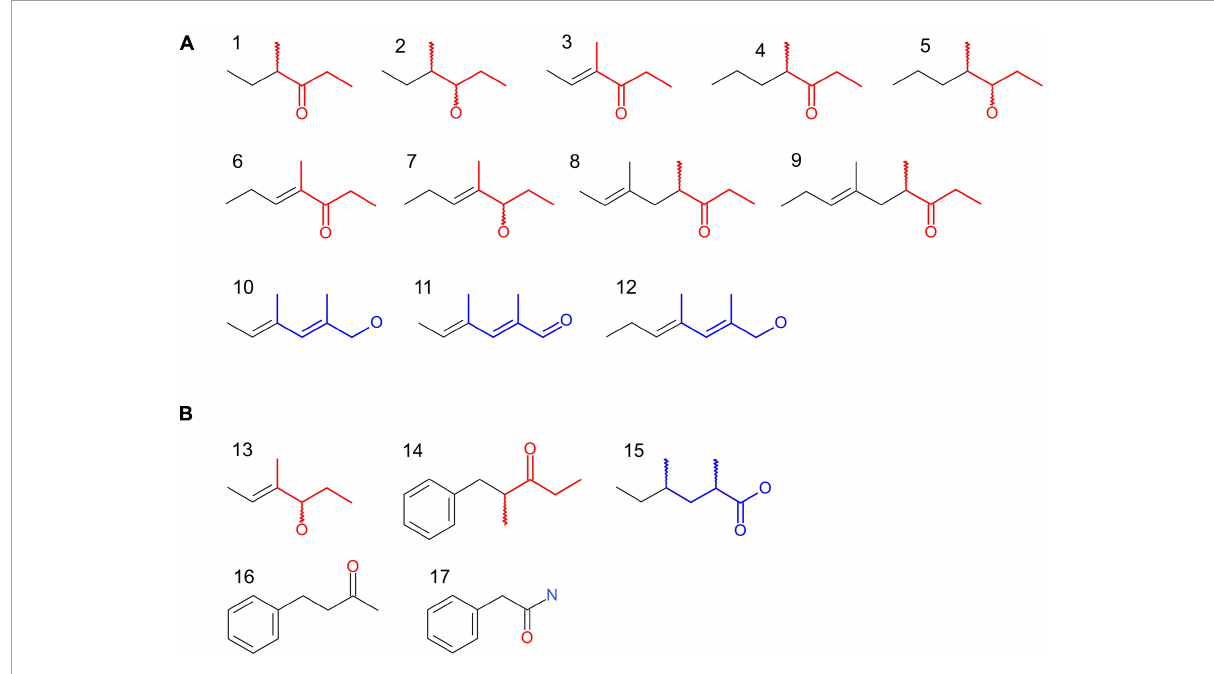
FIGURE1 The growing pool of sclerosomatid compounds (SCs): past and present. Compounds: (1) 4-methyl-hexan-3-one; (2) 4-methyl-hexan-3-ol; (3) ( E )-4-methyl-4-hexen-3-one; (4) 4-methyl-heptan-3-one; (5) 4-methyl-heptan-3-ol; (6) ( E )-4-methyl-4-hepten-3-one; (7) ( E )-4-methyl-4-hepten-3-ol; (8) ( E )-4,6-dimethyl-6-octen-3-one; (9) ( E )-4,6-dimethyl-6-nonen-3-one; (10) ( E,E )-2,4-dimethyl-2,4-hexadien-1-ol; (11) ( E,E )-2,4-dimethyl-2,4-hexadienal; (12) ( E,E )-2,4-dimethyl-2,4-heptadien-1-ol; (13) ( E )-4-methyl-4-hexen-3-ol; (14) ( R )-2-methyl-1-phenyl-pentan-3-one; (15) (2 R ,4 R )-2,4-dimethylhexanoic acid; (16) 4-phenyl-butan-2-one; (17) 2-phenyl-acetamide. (A) SCs as known from literature (Ekpa et al., 1985). Compounds 1–12 are “classical” SCs sensu stricto as already described from North American Leiobunum (nine species) and Hadrobunus (one species). All compounds are acyclic components, arranged in two chemically distinguishable subgroups. Subgroup 1 shows the “4-methyl-3-one” or “4-methyl-3-ol” motif (in red). Subgroup 2 is characterized by the “2,4-dimethyl-1-ol” and “2,4-dimethyl-1-al” motif (in blue). Compounds of subgroup 2 can be converted into compounds of subgroup 1 by a formal addition of an ethyl group to the carbonyl C atom. (B) Novel SCs, as found in the present study for European Nelima spp. and N. paessleri from USA. Compound 13 [=peak A: ( E )-4-methyl-4-hexen-3-ol] is a new SC, showing the typical chemistry of SCs of subgroup 1. It has been detected for the first time in N. paessleri and represents the corresponding alcohol to ( E )-4-methyl-4-hexen-3-one